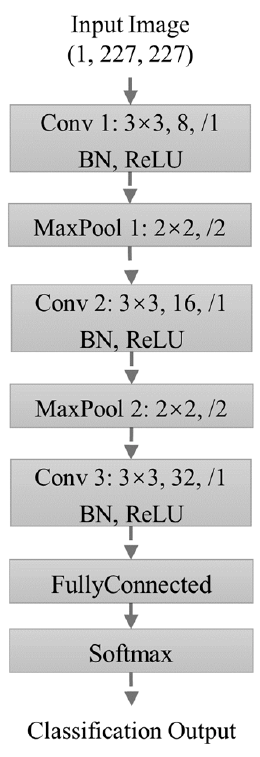
Figure 3. Flowchart of affinity propagation clustering.